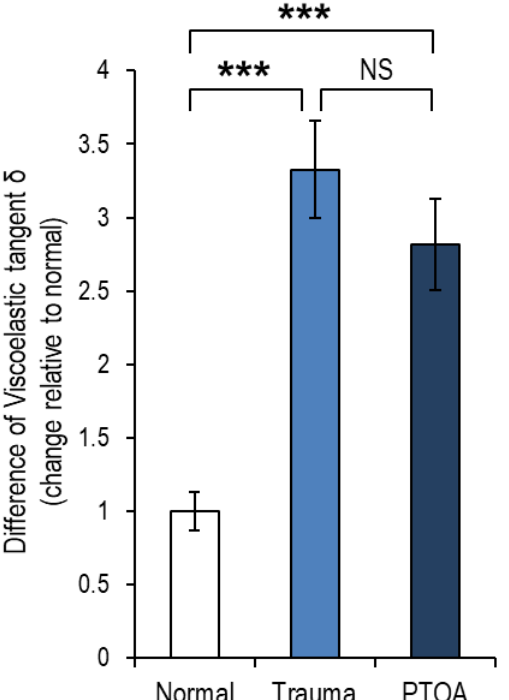
Figure 3. Dynamic Mechanical Analysis (DMA). Difference of viscoelastic tan delta ( δ ) on mechanical loaded knee (Trauma vs. PTOA) vs. contralateral knee. Data are represented as mean ± SD. NS: not significant, *** p < 0.001. ( n = 3 per group).